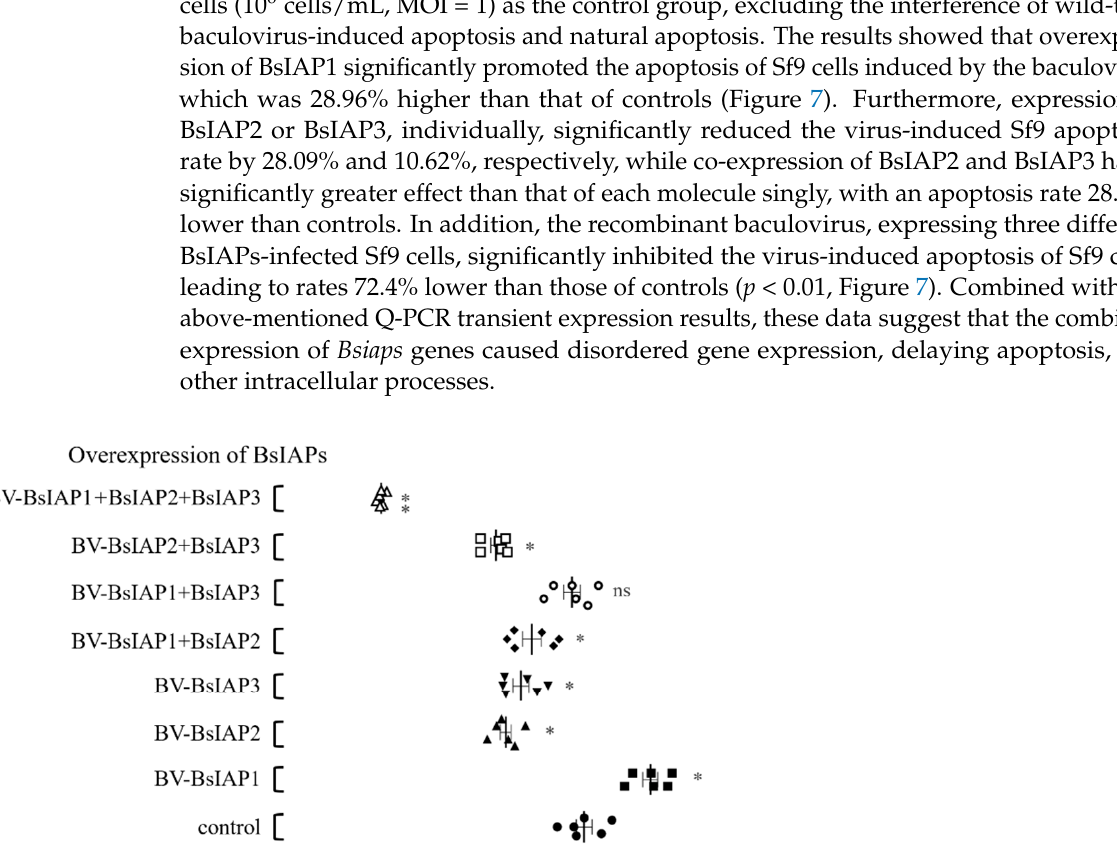
Figure 8. Effects of BsIAP overexpression on VP39 capsid protein levels. * p < 0.05, ** p < 0.01. After 48 h of infection with recombinant baculovirus stably expressing BsIAPs, total RNA was extracted, and the expression of vp39 gene was determined by reverse transcription PCR. The VP39 expression is relative to the control group (baculovirus AcBV-gfp expressing fluorescent protein only). To more clearly reveal the effects of different BsIAPs on virus-induced apoptotic cells, TCID 50 was used to determine nucleocapsid proliferation rates at different times. Referring to Section 2.9, the baculovirus released from the supernatant of cells expressing BsIAP was collected, and the baculovirus genome in the cell supernatant was quantified